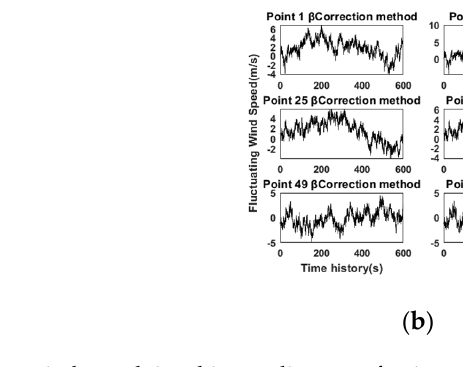
Figure 6. 10 min fluctuating wind speed time history diagram of points: ( a ) One-dimensional space for points 20, 21, 40; ( b ) Two-dimensional space for points 1, 25,